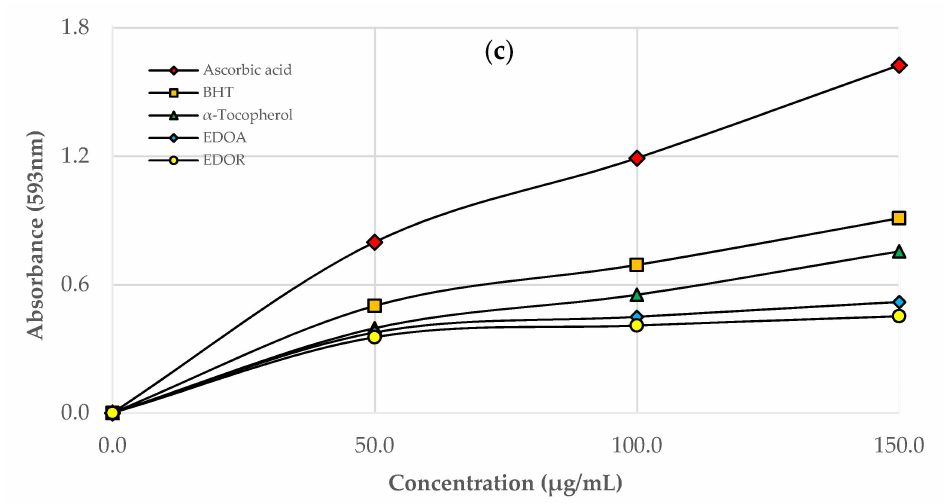
Figure 2. The reducing abilities of ethanol extract of aerial parts (EDOA) and roots (EDOR) of sahlep ( D. osmanica ) and standards: ( a ) Fe 3+ reducing ability; ( b ) Cu 2+ reducing ability; ( c ) FRAP reducing ability.